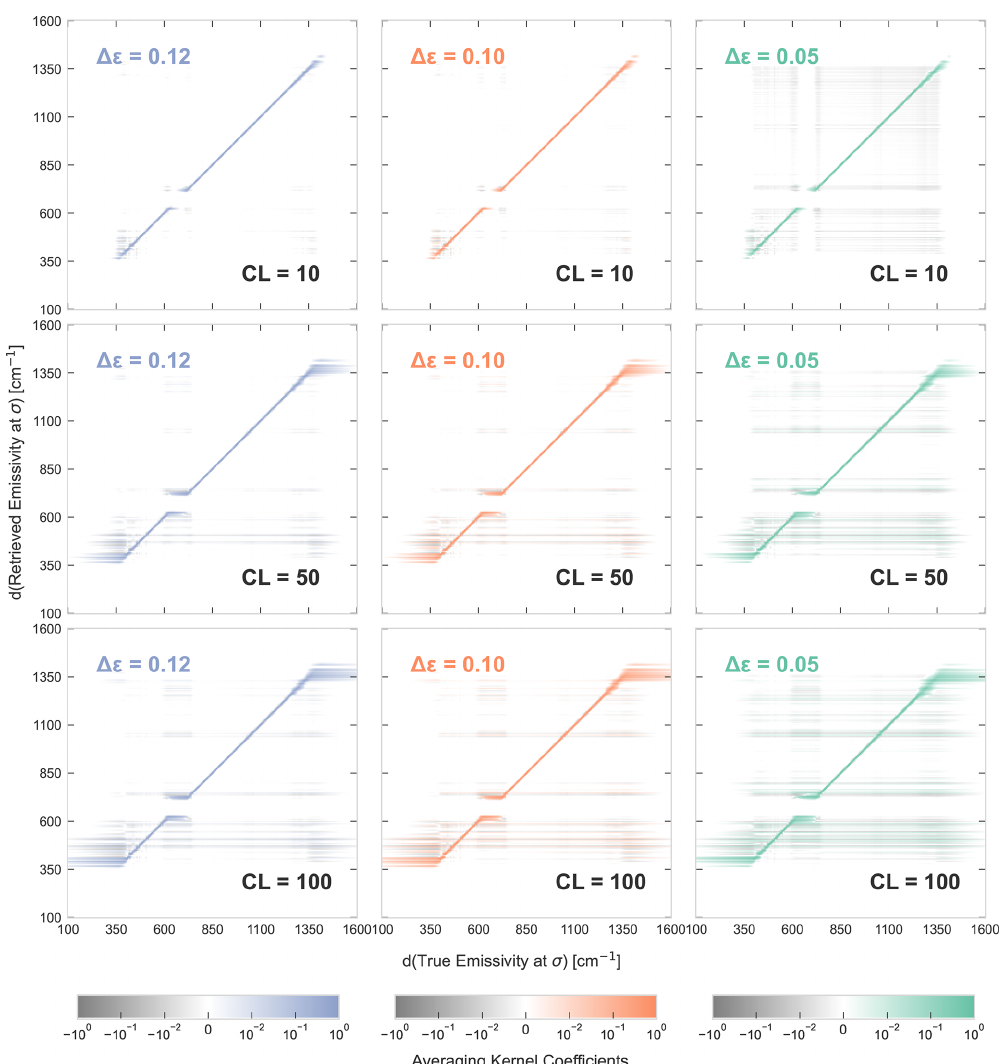
Figure B2. Averaging kernel coefficients (see Eq. 7) for the same nine cases shown in Fig. B1. The colour coding of the emissivity a priori uncertainty (cid:49)(cid:15) is kept the same as Fig. B1, and its value is 0.12, 0.1 and 0.05 for columns 1, 2 and 3, respectively. Rows 1, 2 and 3 show cases with a correlation length (CL) of 10, 50 and 100, respectively. The colour scales are shown at the bottom of each column and are the same for each figure. The values are plotted with a lower threshold of ± 10 − 3 for